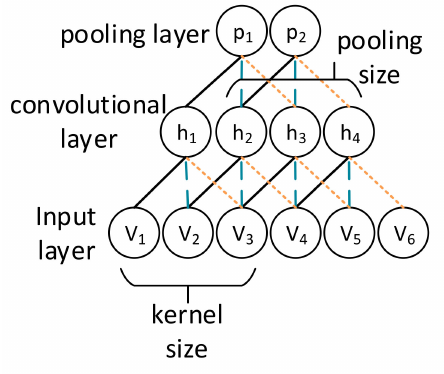
Figure 2. A basic convolutional neural network (CNN)